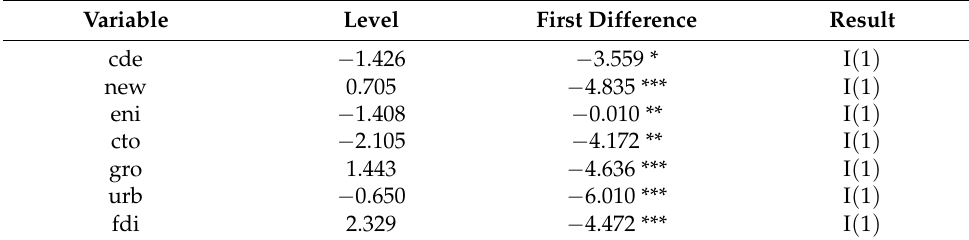
Table 2. Results of unit root test.